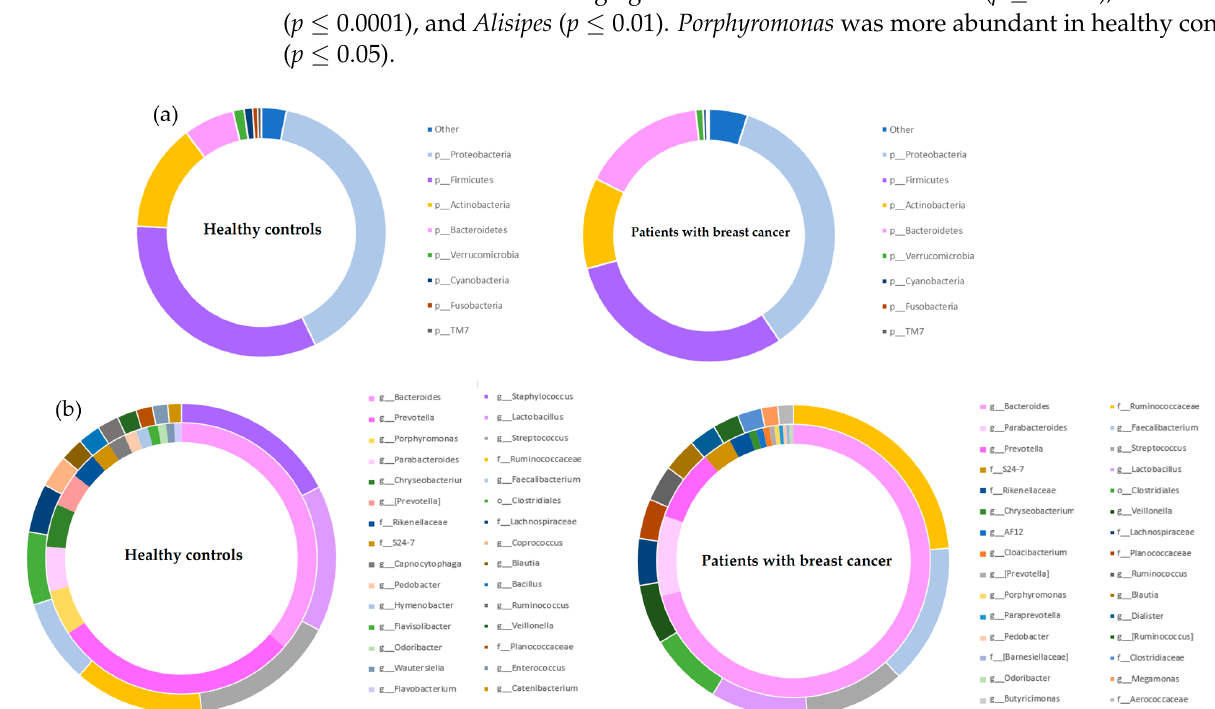
Figure 1. Phyla proportions of total microbiome in healthy controls and breast cancer patients. ( a ) Graph listing phyla-specific abundances in healthy controls and breast cancer. ( b ) Genera-specific abundances in healthy controls and breast cancer. Inner circles show genera belonging to Bacteroidetes, and outer circles show genera belonging to Firmicutes.